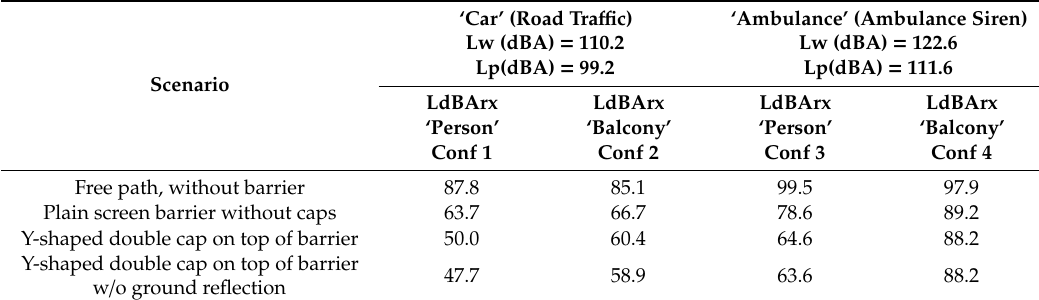
Table 1. Global sound pressure level (SPL) (dBA) at receiver positions.